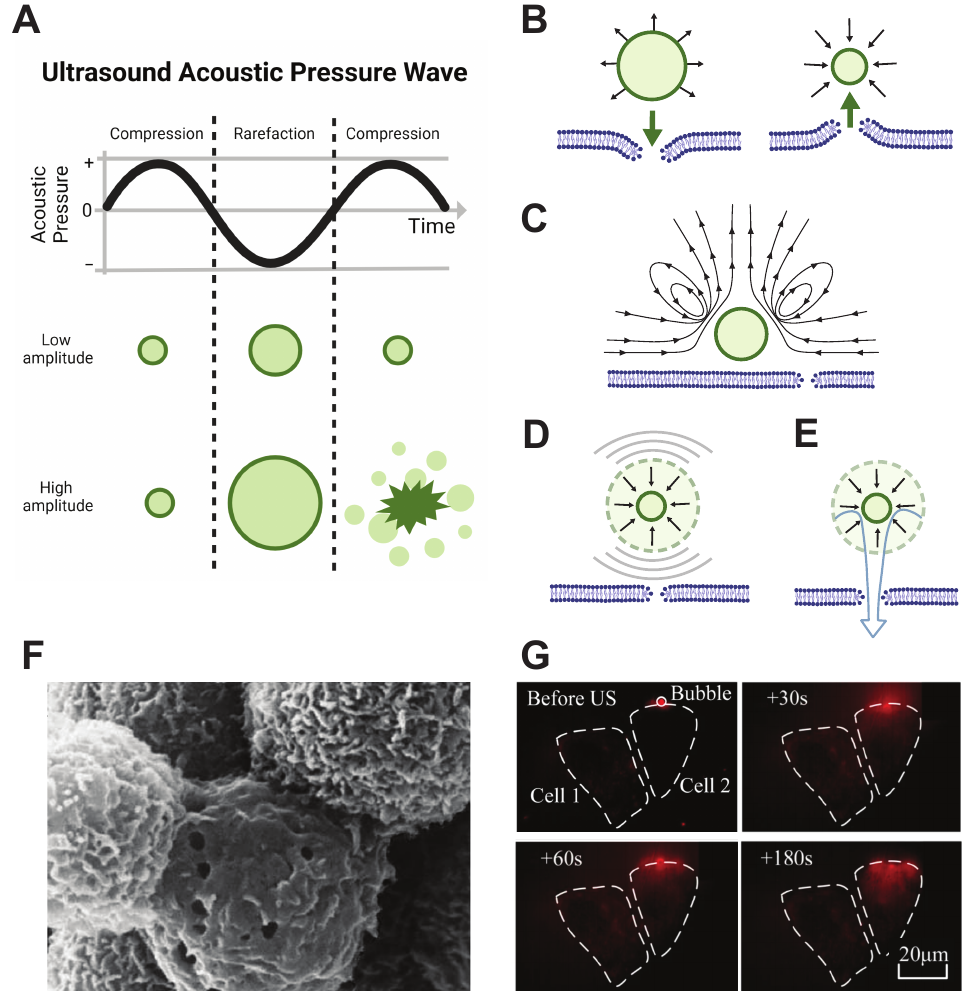
Figure 2. Microbubble cavitation induces sonoporation of local cell membranes. ( A ) During the sinusoidal alternating cycle of compression and rarefaction from the ultrasound pressure waves, gas-core microbubbles contract and expand in diameter. In stable cavitation (top row), occurring at lower acoustic pressure amplitudes, microbubbles stably oscillate between expansion and contraction, whereas at higher acoustic pressures, inertial cavitation can occur (bottom row), in which the mi- crobubble expands and then implodes, collapsing and fragmenting the bubble. Schematic illustrations in ( A ) created with Biorender.com, and based on those from [57], Springer Nature, 2015, and [58], IvySpring International Publisher, 2012. ( B – E ) Both stable and inertial cavitation can create local dynamics which may cause sonoporation. Illustrations are based on those from [42], copyright 2017. Reproduced by permission of Taylor and Francis Group, LLC, a division of Informa plc. ( B ) Stable microbubble cavitation may cause sonoporation by pushing the cell membrane during expansion or pulling the membrane during contraction. ( C ) Stable cavitation creates local fluid microstreaming, which can also cause membrane permeation. ( D ) During inertial cavitation, resultant shockwaves from bubble implosion can create pores in cell membranes. ( E ) Bubble collapse during inertial cavitation can also cause fluid jet formation which can permeate the cell membrane. ( F ) Scanning electron microscopy images show the presence of pores in cell membranes following ultrasound exposure in the presence of microbubbles. Image reprinted from [46], copyright 2005, with permission from Elsevier. ( G ) Ultrasound stimulation in the presence of adjacent microbubbles causes cell membrane permeability, facilitating rapid cell uptake of local fluorescence marker propidium iodide (red) through pores created from sonoporation. Images reprinted from [53], Springer Nature,